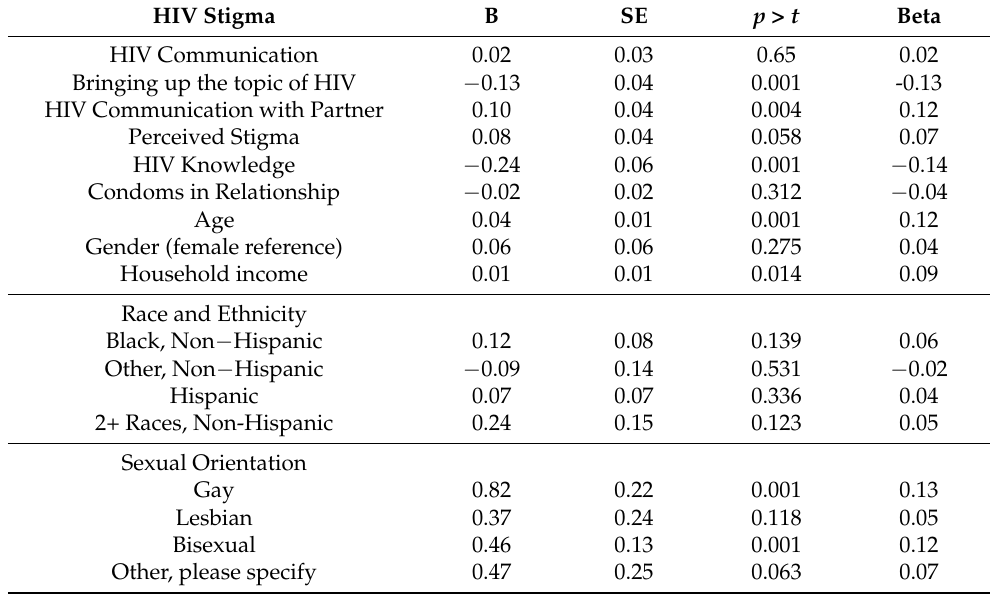
Table 4. Multiple Linear Regression on HIV stigma (N = 1421).